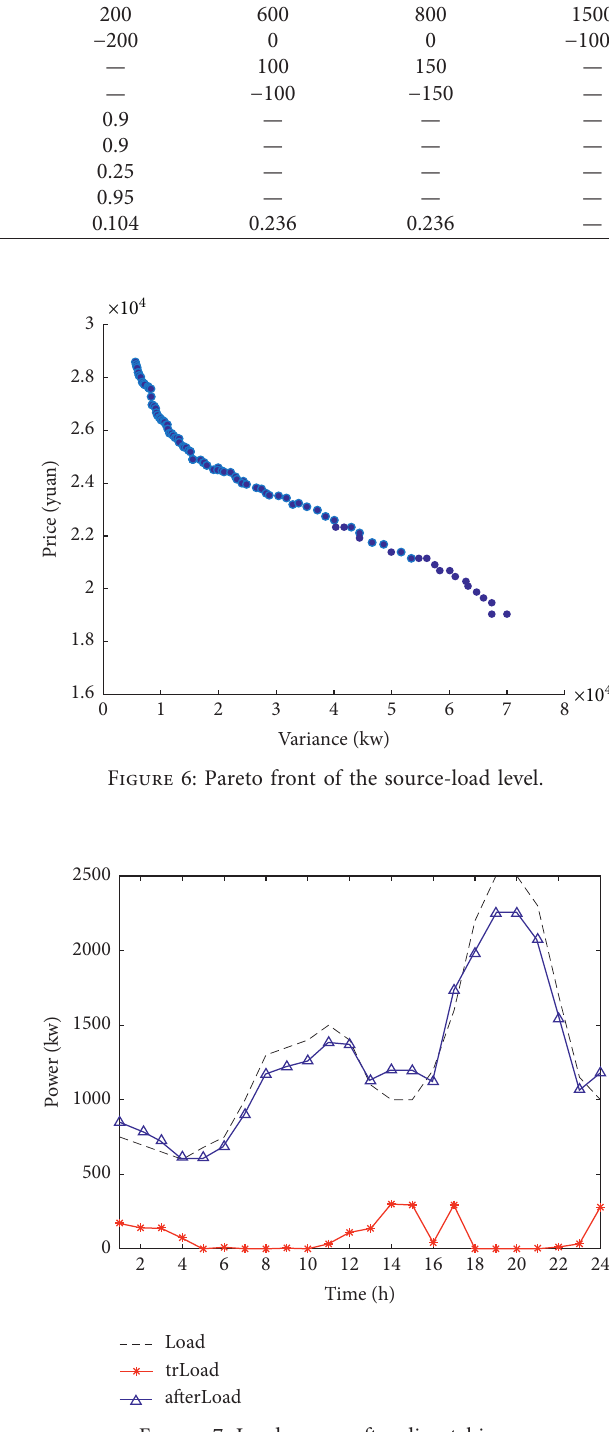
Figure 7: Load curves after